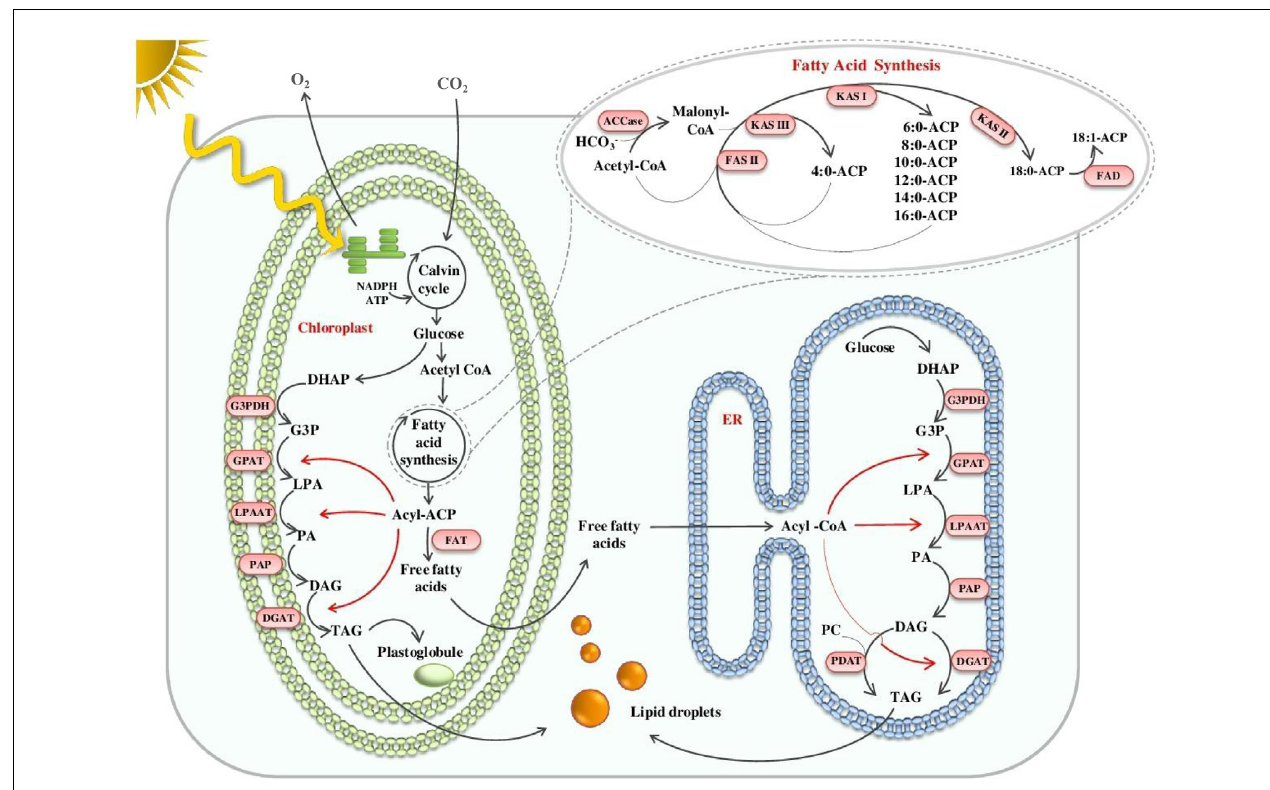
FIGURE 1 | Schematic illustration of TAG synthesis in microalgae. NADPH; Nicotinamide adenine dinucleotide phosphate; ATP, Adenosine Triphosphate; DHAP, dihydroxyacetone phosphate; G3P/G3pDH, Glyceraldehyde 3-phosphate / G3P dehydrogenase; GPAT, Glycerol 3-phosphate acyltransferase; PA/LPA/LPAAT/PAP, Phosphatidic acid/Lyso-PA/LPA acyltransferase/PA phosphatase; DAG/DGAT, di-Acylglycerol/ DAG acyltransferase; FAT, Fatty acyl-ACP thioesterase; ACP, Acyl-carrier protein; ER, Endoplasmic reticulum; PC, Phosphatidylcholine; PDAT, Phospholipid:DGAT; ACCase, Acetyl-CoA carboxylase; FAS, Fatty acid synthase; KAS, 3-ketoacyl-ACP synthase; FAD, Flavin adenine